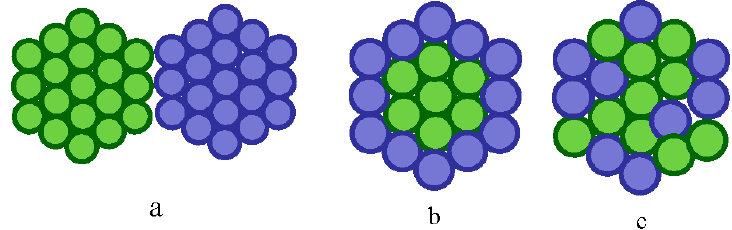
Figure 4. Catalytic structures: ( a ) heterogeneous, ( b ) core-shelled and ( c ) alloyed.